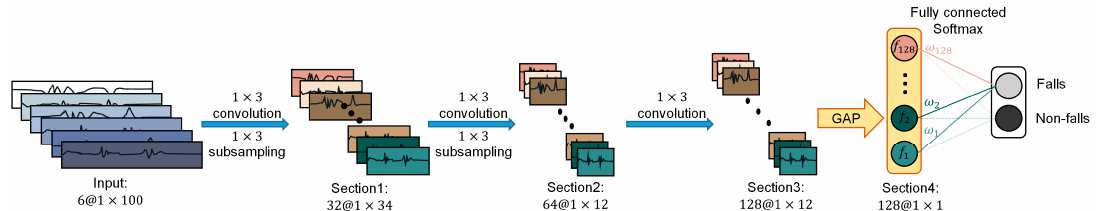
Figure 3. CNN network architecture: The network consists of three 1D convolutional layers with 32 output channels, 64 channels, and 128 channels, respectively, one global average pooling layer, one linear fully-connected layer, and one softmax layer. The input data dimension is (6, 100), and the output is the classification result of falls or non-falls.